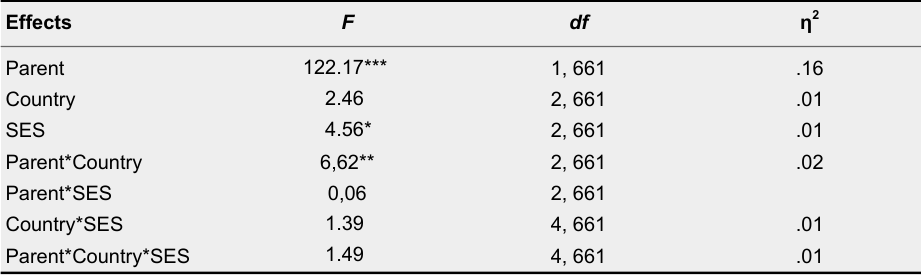
Principal and Interaction Effects for Authoritative Parenting